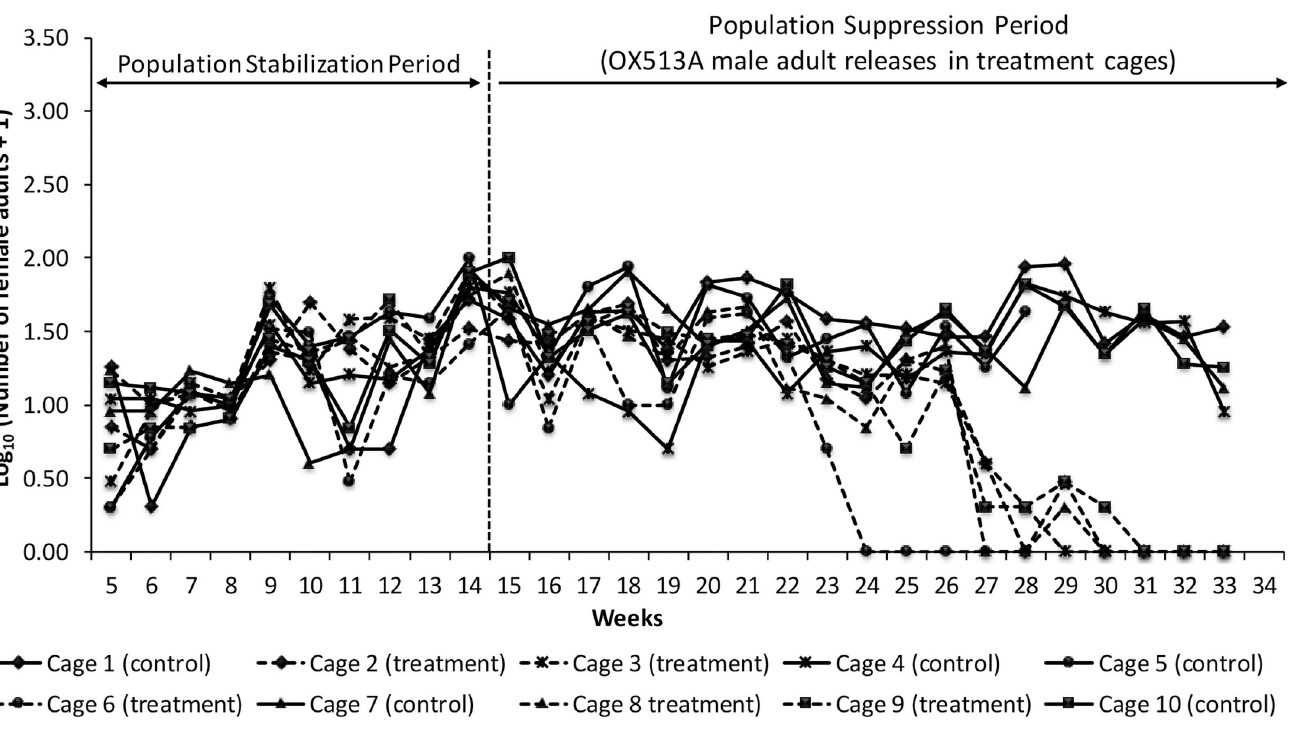
Fig 6. Female adult sampling using BG sentinel traps in control and treatment cages (week 5 to